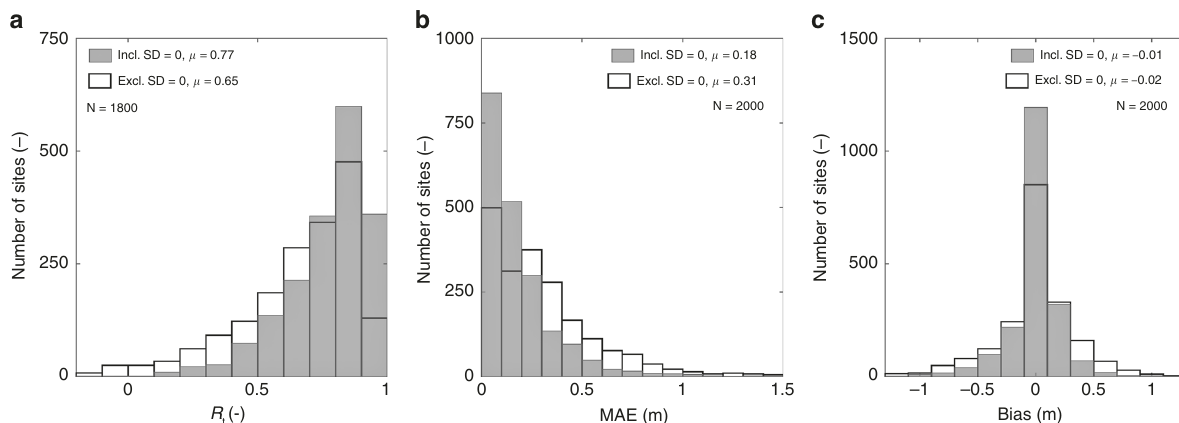
Fig. 6 Histograms of retrieval performance metrics. a – c Histograms of temporal correlation ( R t ; dimensionless), mean-absolute-error (MAE; m), and mean of retrievals minus measurements (bias; m), calculated from time series of weekly snow depth measurements and corresponding Sentinel-1 retrievals, for September 2016 through August 2018. Gray histograms are calculated with all reported measurements, including zero values (Incl. SD = 0); white histograms exclude zero values (Excl. SD = 0), with SD the snow depth (m). Metrics indicate the mean value ( μ ) and the number of sites ( N